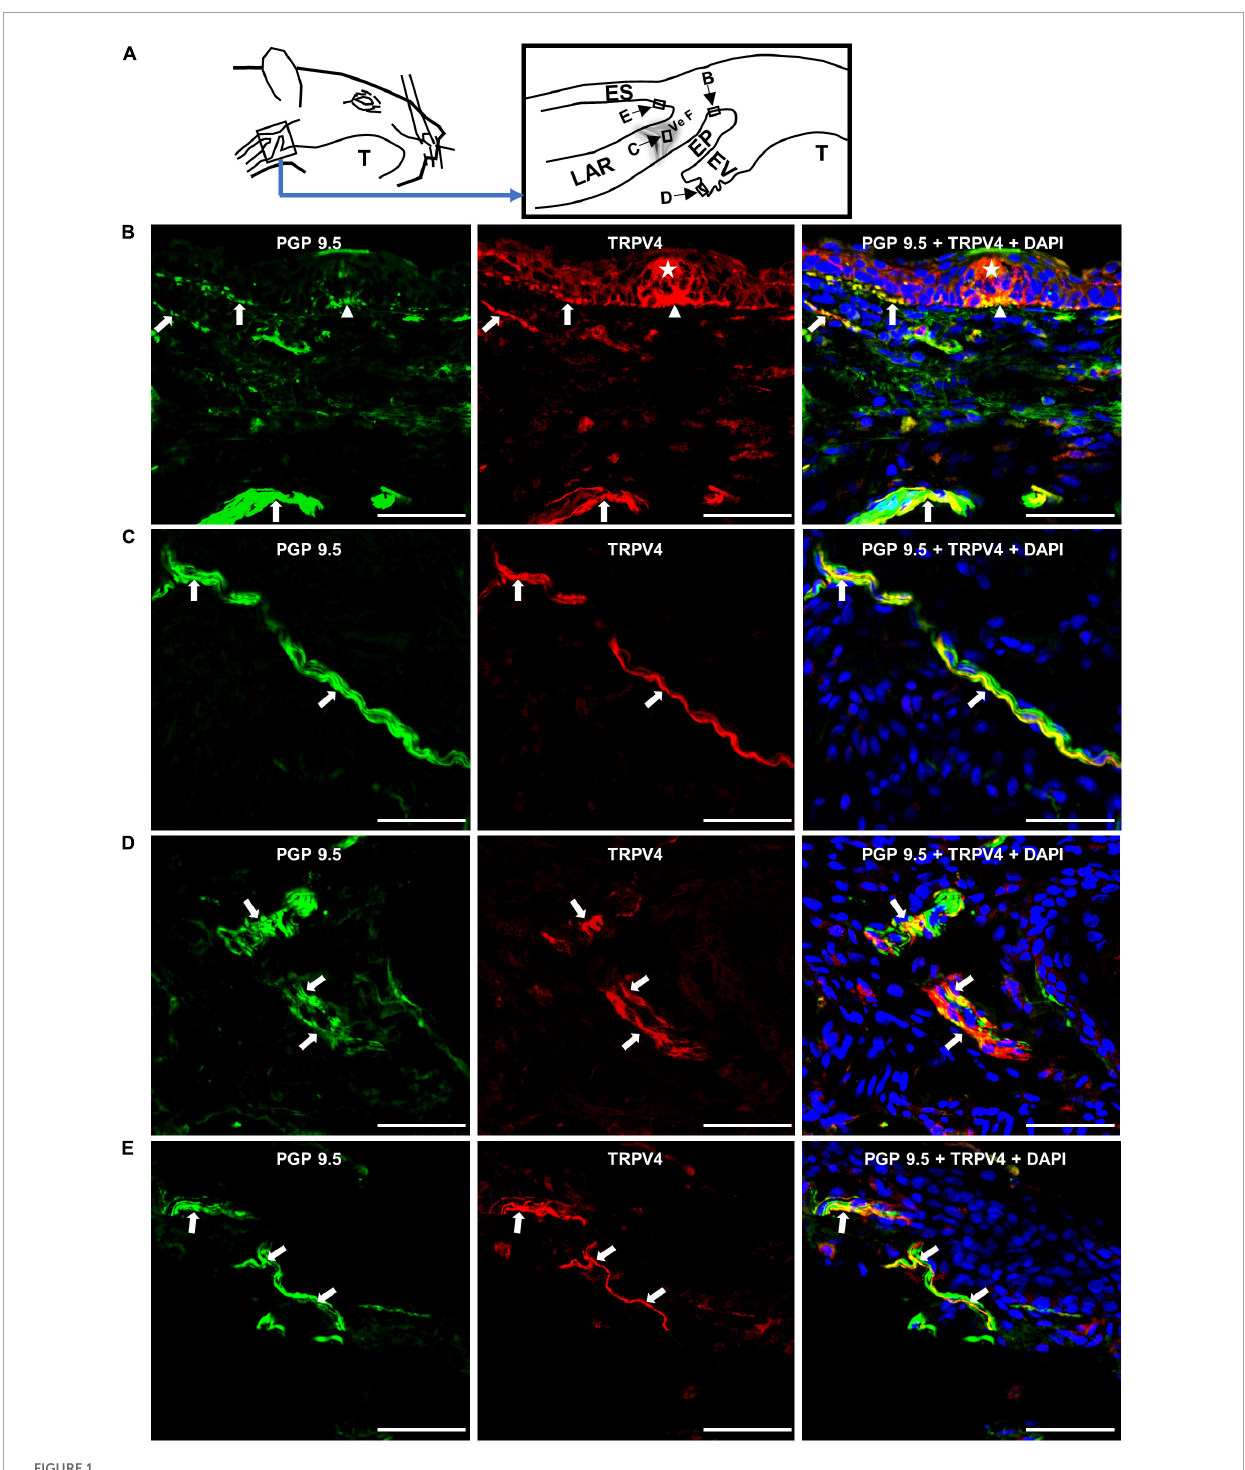
FIGURE1 Nerve fibers in the swallowing-related regions express TRPV4. (A) Schematic of the SLN-innervated laryngopharyngeal and associated laryngeal regions. Rectangles with arrows and letters show the areas where the photomicrographs were taken. Photomicrographs of TRPV4 localization in the (B) epiglottis (EP), (C) vestibular fold (Ve F), (D) epiglottic vallecula (EV), and (E) cervical esophagus (ES). Arrows show examples of TRPV4 on PGP 9.5-expressing nerve fibers in different areas of the swallowing-related regions. The asterisk indicates a taste bud-like structure. Arrowhead indicates a subgemmal neurogenous plaque to the taste bud-like structure expressing TRPV4. Scale bars = 50 µ m. LAR, larynx; T, tongue.